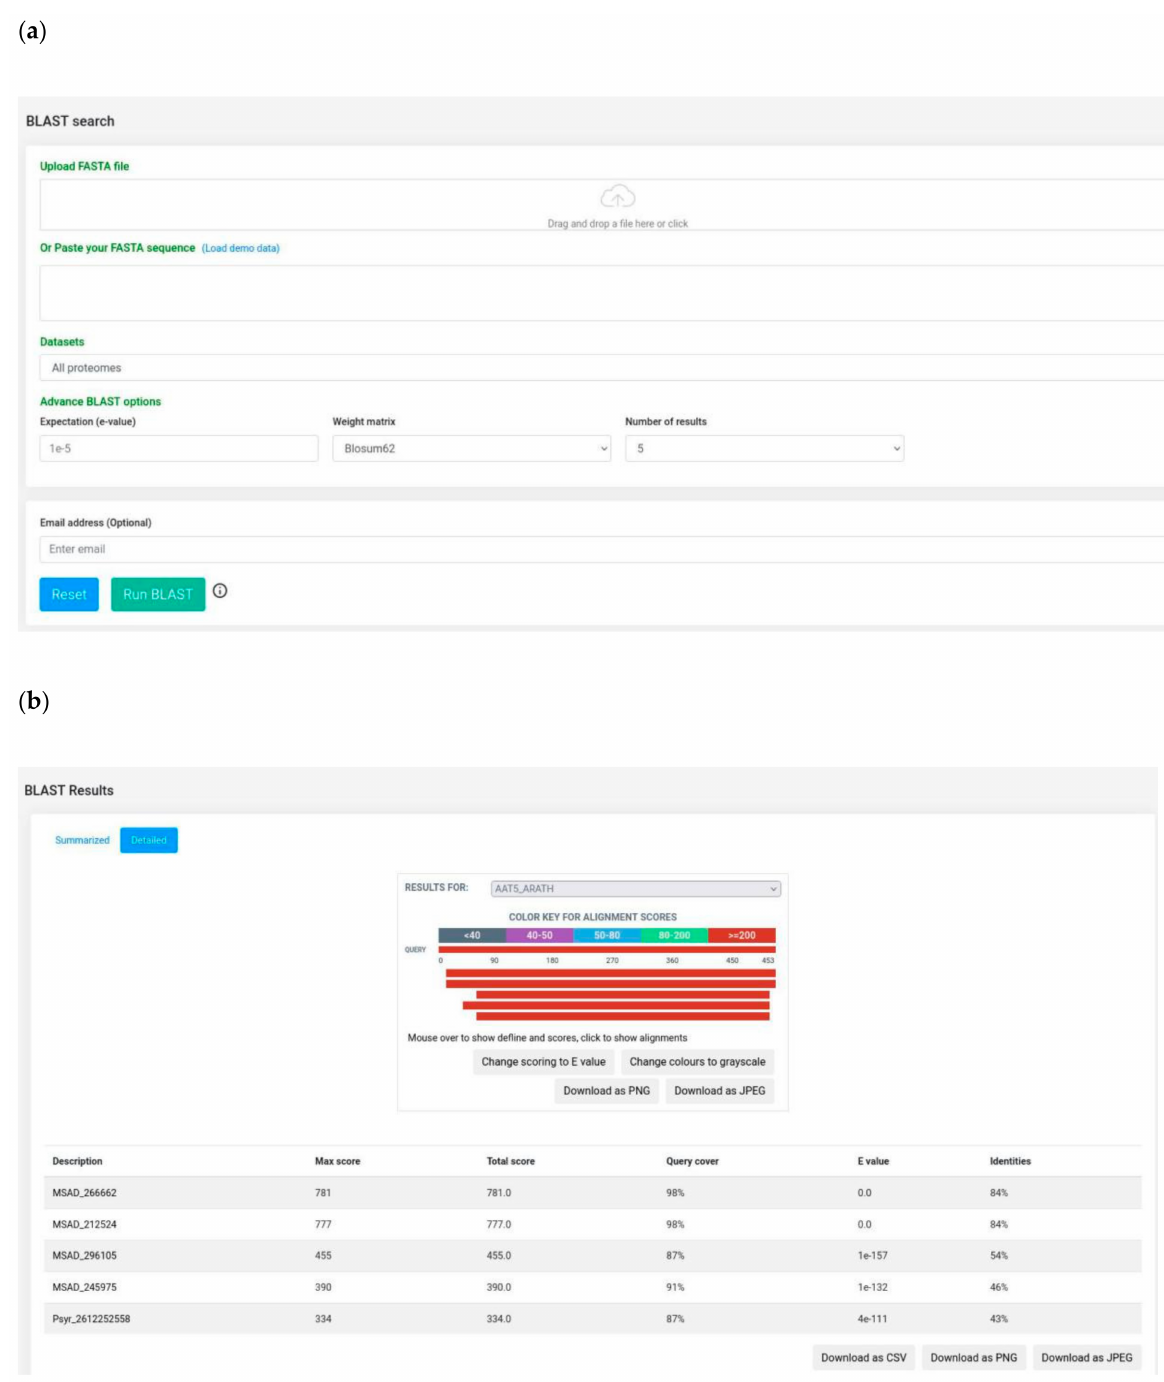
Figure 5. BLAST search module: ( a) BLAST search interface; ( b ) visualization of BLAST alignments using